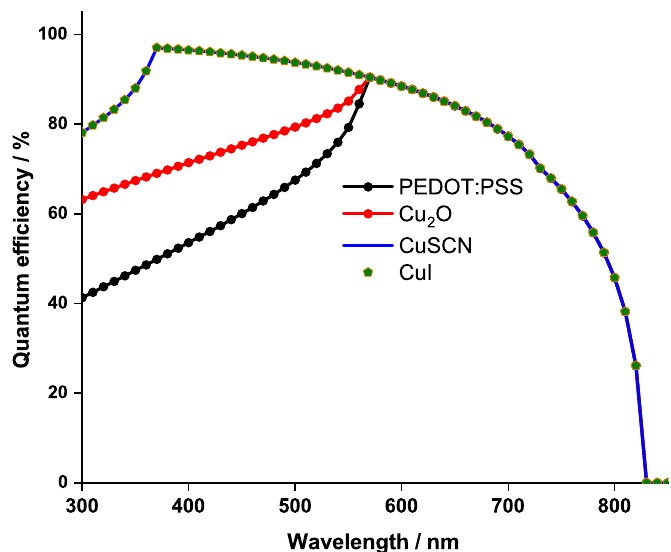
Figure 5. Quantum Efficiency for the PSCs with different HTL materials.